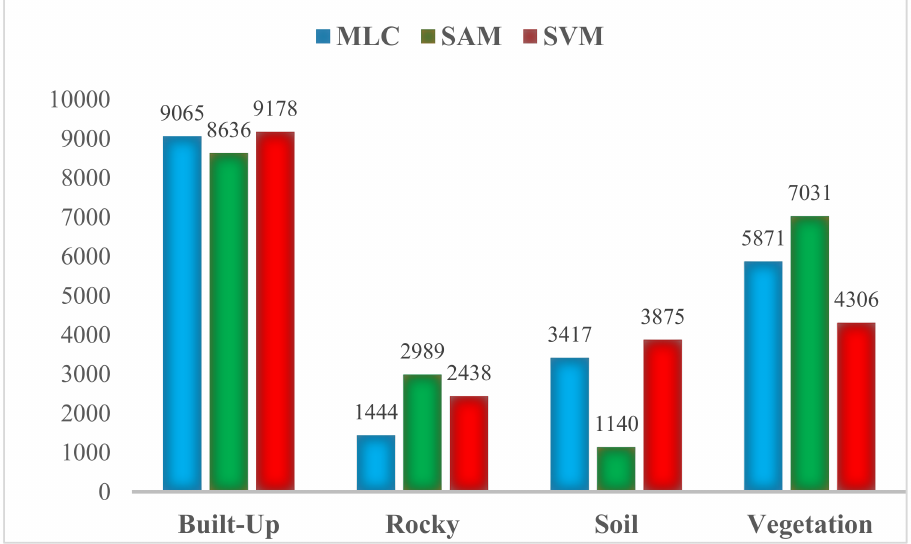
Figure 11. Predicted extent of land cover classes for